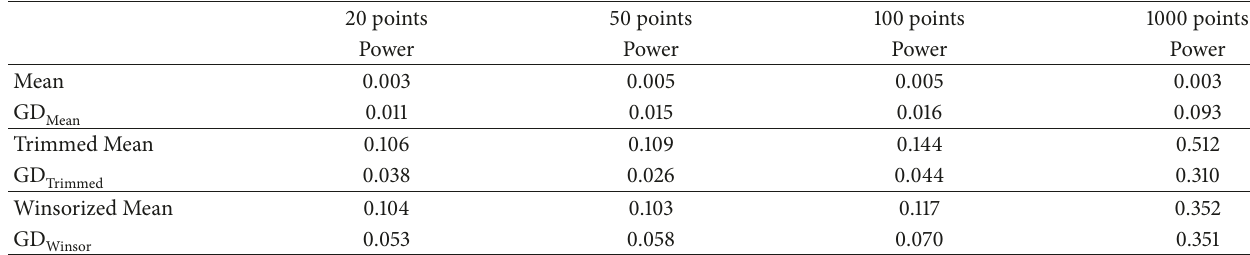
Table 21: Log-normal distributions with 50% noise level.